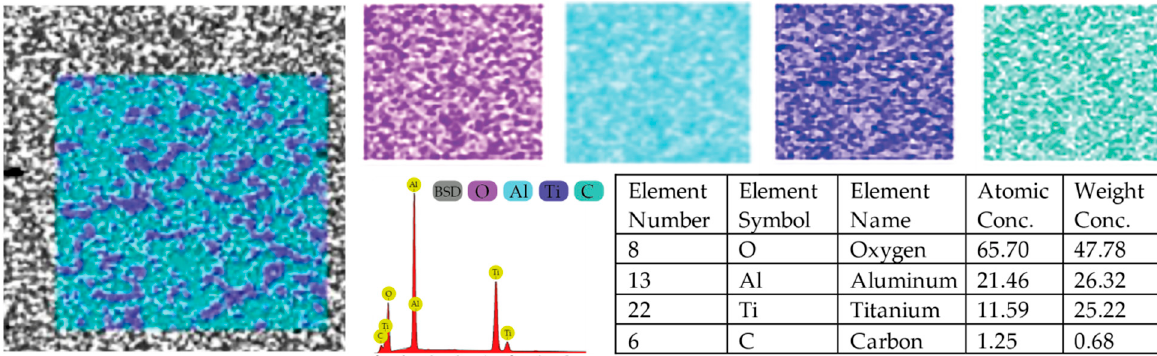
Figure 2. EDS micrographs depicting chemical composition of the ceramic workpiece measured using Phenom ProX. The impact of the machine parameter SSol on the material removal rate is shown in Figure 3. EDM regimes with SSol = 45, 55, and 80 are denoted as EDM1, EDM2, and EDM3, respectively. As seen in Figure 3, the material removal rate increases as SSol grows.